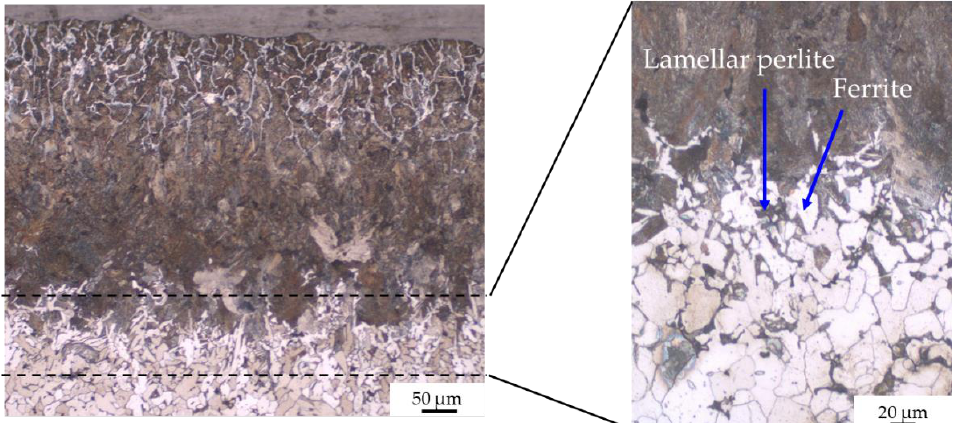
Figure 5. Magnification of zone 3 (sintering with graphite foils without coating): OM images after chemical etching.